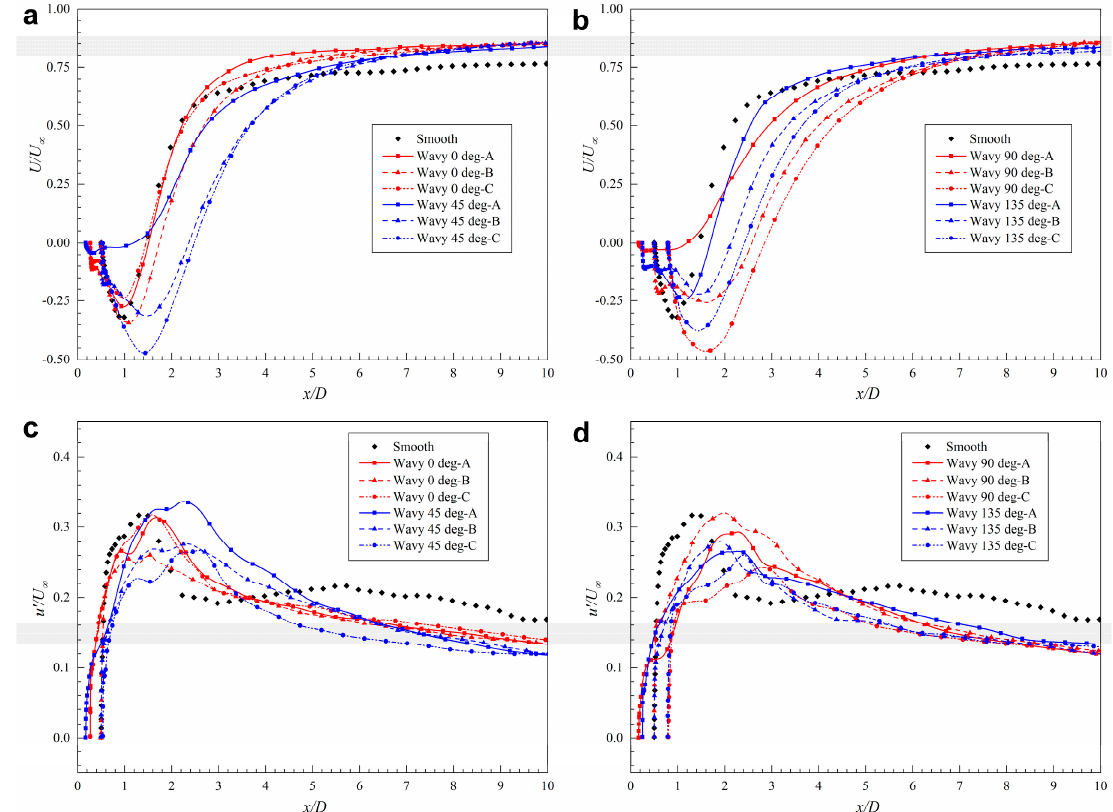
Figure 9. Comparison of ( a – b ) average streamwise velocity and ( c – d ) r.m.s. streamwise velocity distributions of the smooth cylinder and wavy cylinder A3 at four rotation angles.